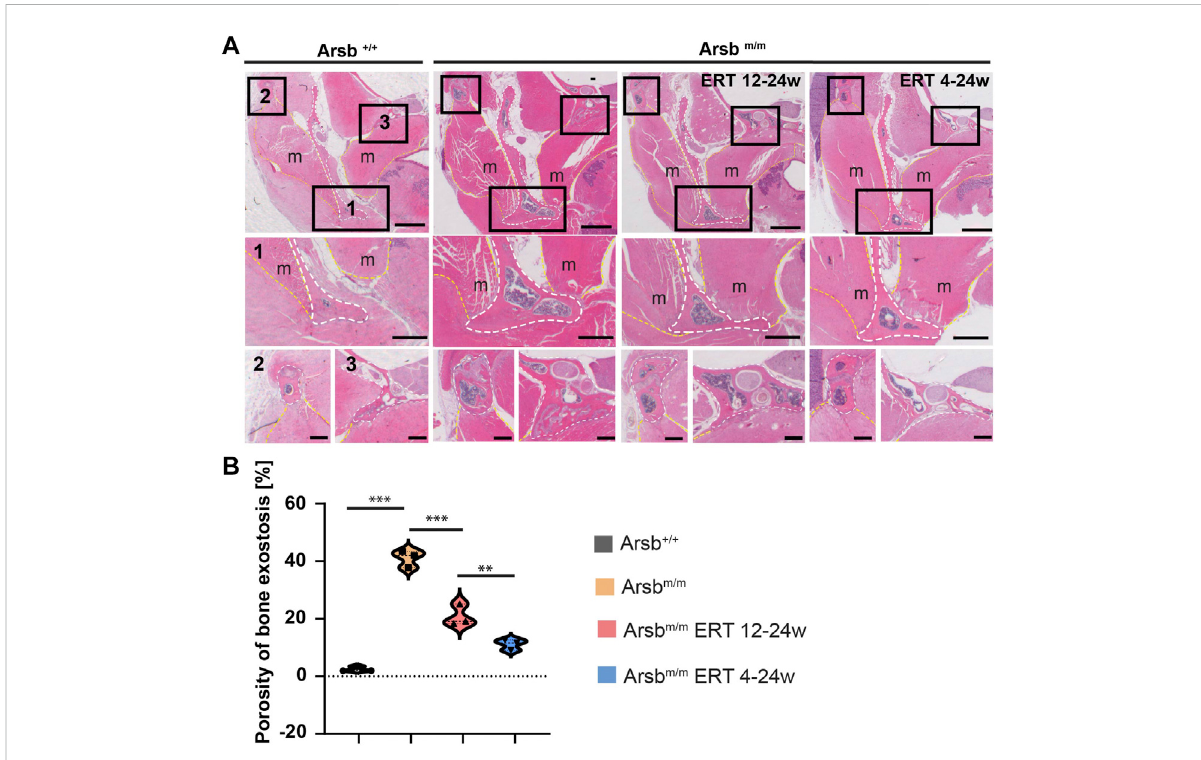
FIGURE 3 Decalci fi edsectionsofthemandibularridge (A) Decalci fi edsectionsofthemandibularridge(whitedashedlines)showahighermagni fi cationof the lower mandibular rim 1), zygomatic arch 2), and mastoid process 3). The marked regions show the greater thickness of the bone cortex and increased porosity in Arsb m/m mice. Bone thickness and porosity are reduced in Arsb m/m mice with ERT 12-24w and ERT 4-24w. In addition, exostosesarelesspronounced in Arsb m/m ERT4-24w mice. Scalebars=1 mm(upperpanel), 500 µm(middlepanel)and250 µm(lowerpanel). m = muscle, TMJ = temporomandibular joints (B) Quanti fi cation of bone porosity at theinferior border of themandible. * p < 0.05, ** p < 0.01, *** p <